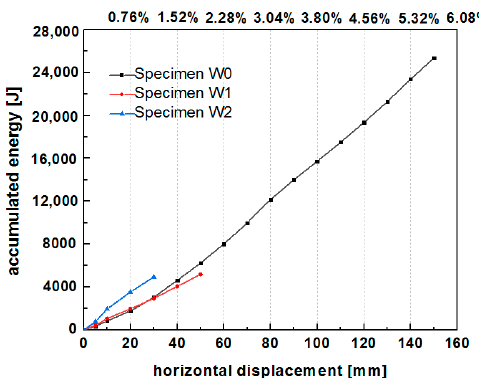
Figure 24. Cumulative dissipated energy of Specimens W0, W1, and W2.